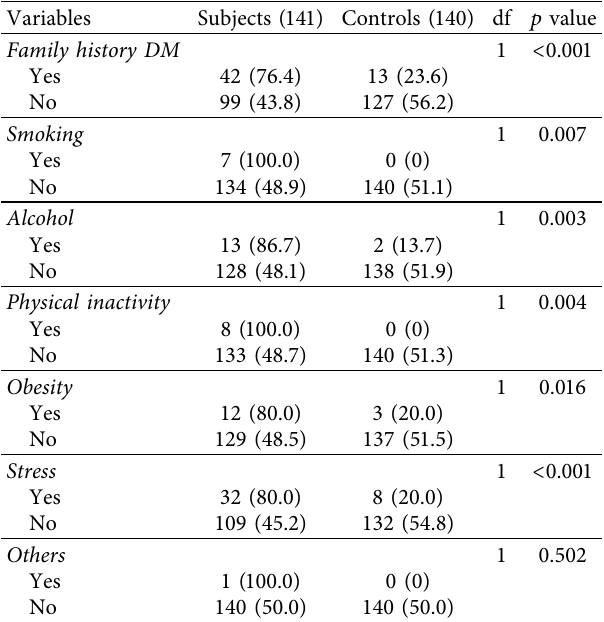
Table 3: Risk factors for DM. Table 2: History of past and present symptoms of anaemia dia-